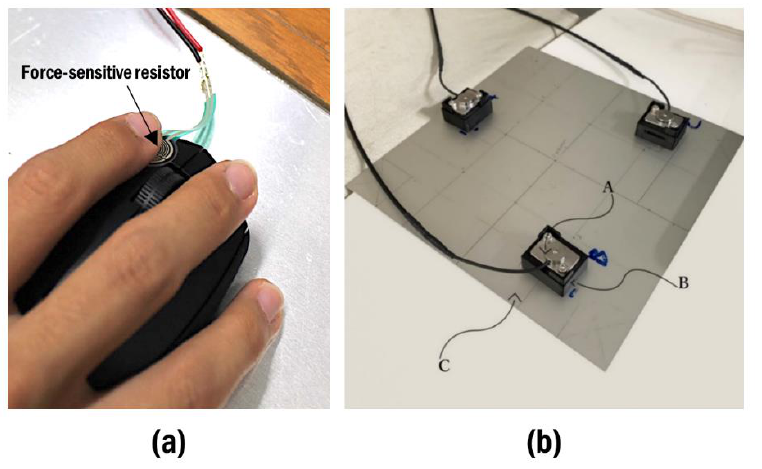
Figure 3. Force sensors used in the experiment. ( a ) A force-sensitive resistor secured on the left button of pointing device; ( b ) the internal structure of the custom-made force plate used in the experiment; ( A ) load cell, ( B ) loading fixture, and ( C ) the base of the force plate.